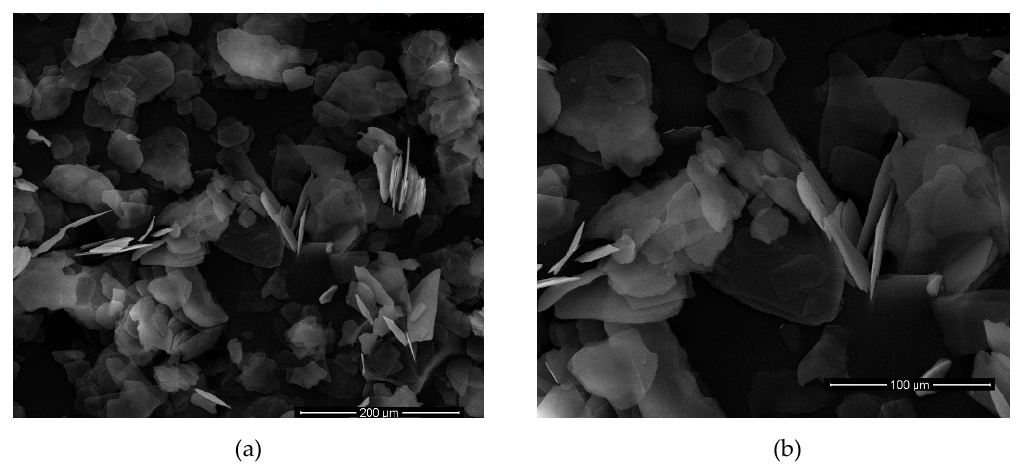
Figure 5. SEM images of M x2c2 sample ( a ) with a sonication time of 7 h (500×); ( b ) same as in 1 ( a ) with higher magnification (1000×).